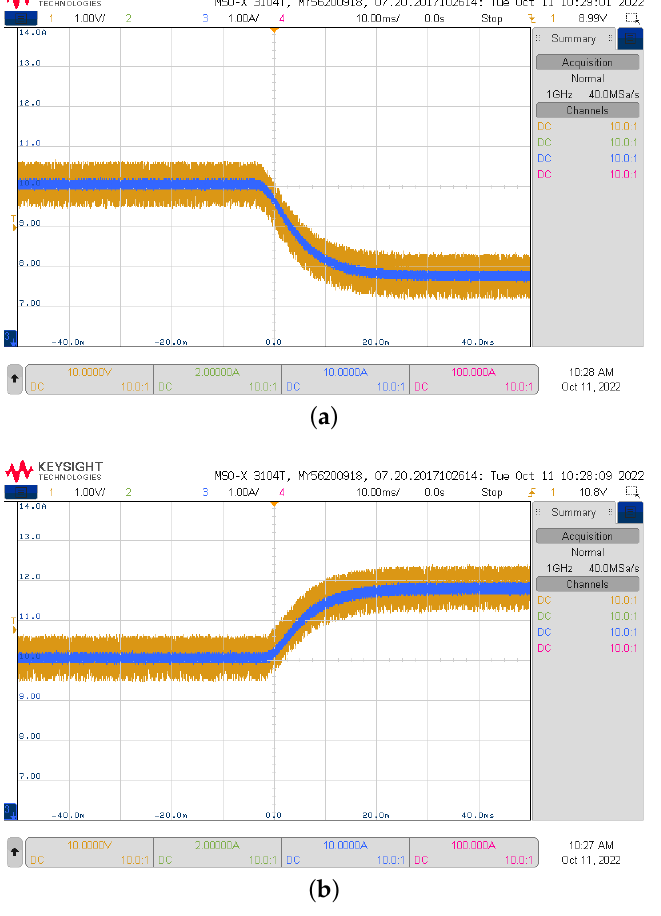
Figure 5. Dynamic response of the estimate ˆ E : ( a ) input voltage changes between 10 to 8 V; and ( b ) input voltage changes between 10 to 12 V. CH1: (1 V/div), CH3: (1